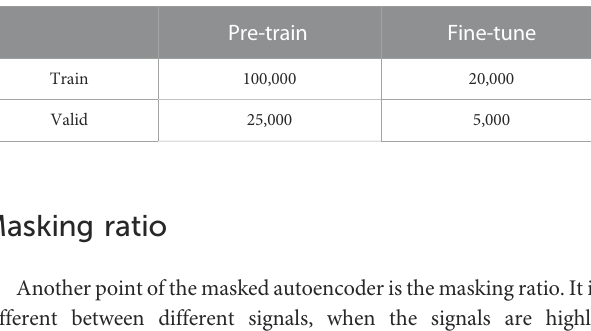
TABLE 1 Size of training and validating datasets.